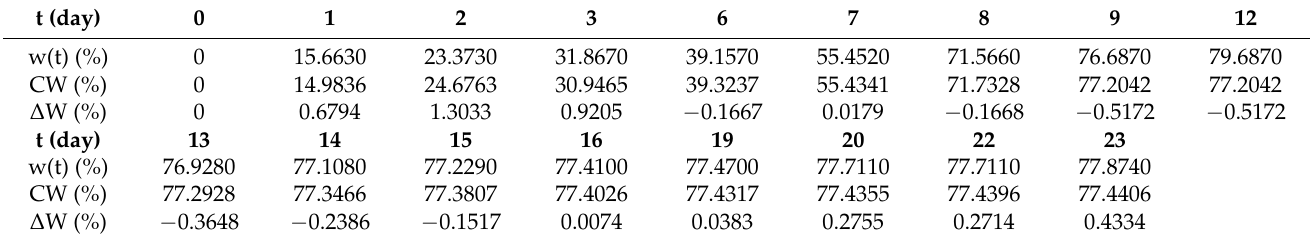
Table 1. Results obtained by applying the new empirical model on the biodegradation data of the glycopolymer depicted in article